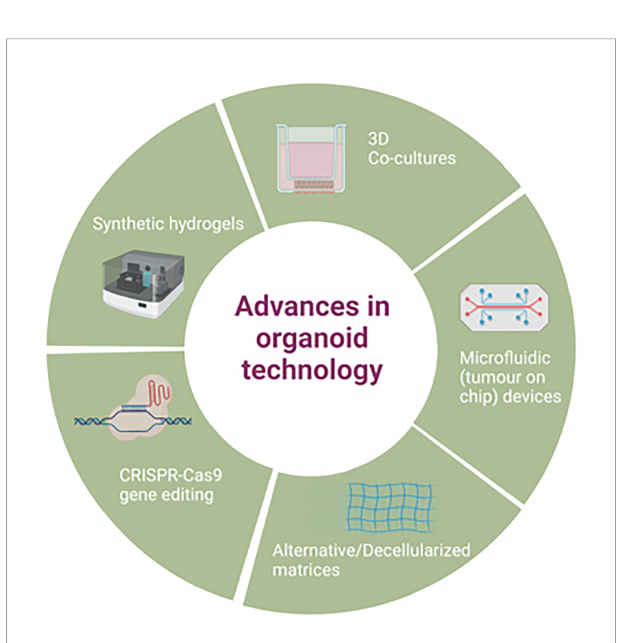
FIGURE 2 | Advances in patient derived organoid